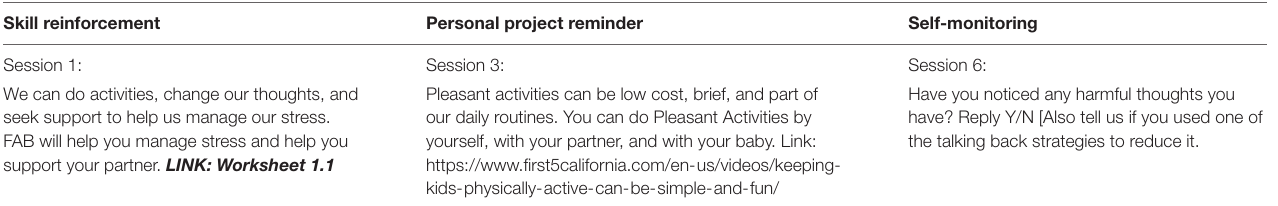
TABLE 2 | Example of the FAB text messages. Skill